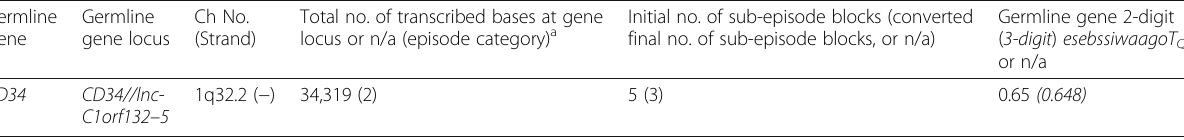
Initial no. of sub-episode blocks (converted final no. of sub-episode blocks, or n/a)